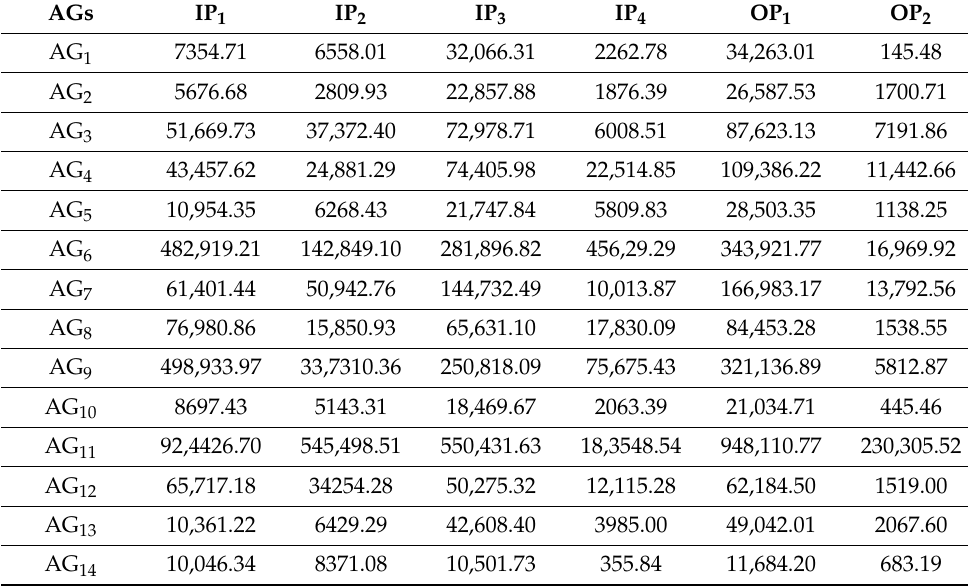
Table 9. Data in 2020 (Unit: 1000 USD).